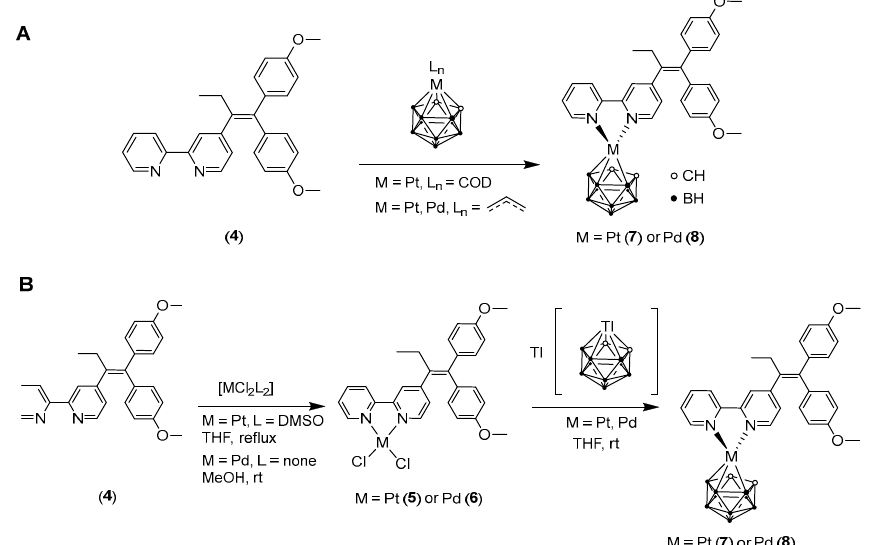
Scheme 1. Incorporation of the nido -carborate dianion in 2,2 ′ -bipyridine complexes: ( A )